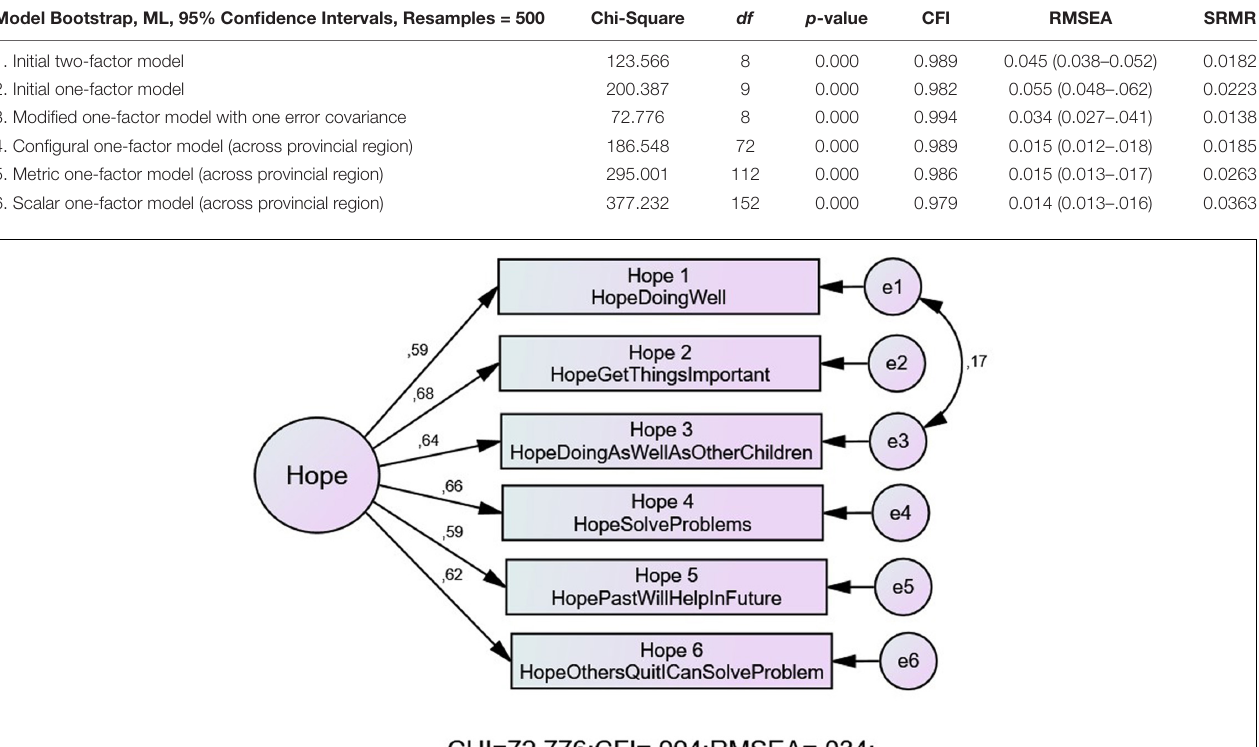
TABLE 1 | Fit indexes for the confirmatory factor models.